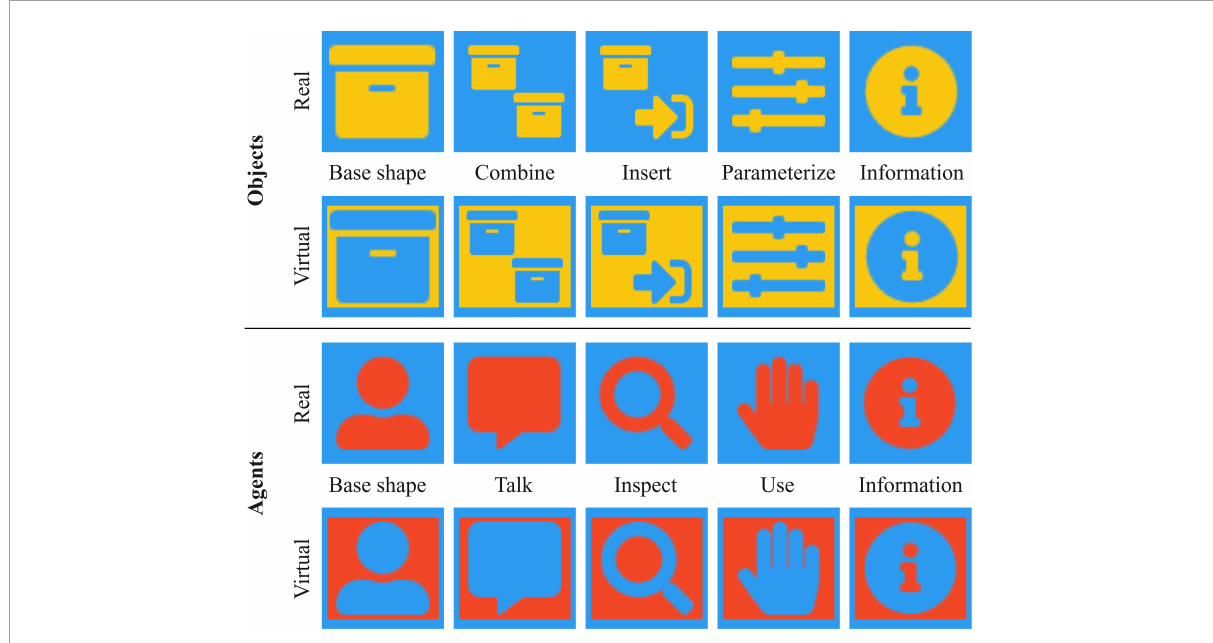
FIGURE5 Distinguishing real and virtual objects and agents in eLuna MR